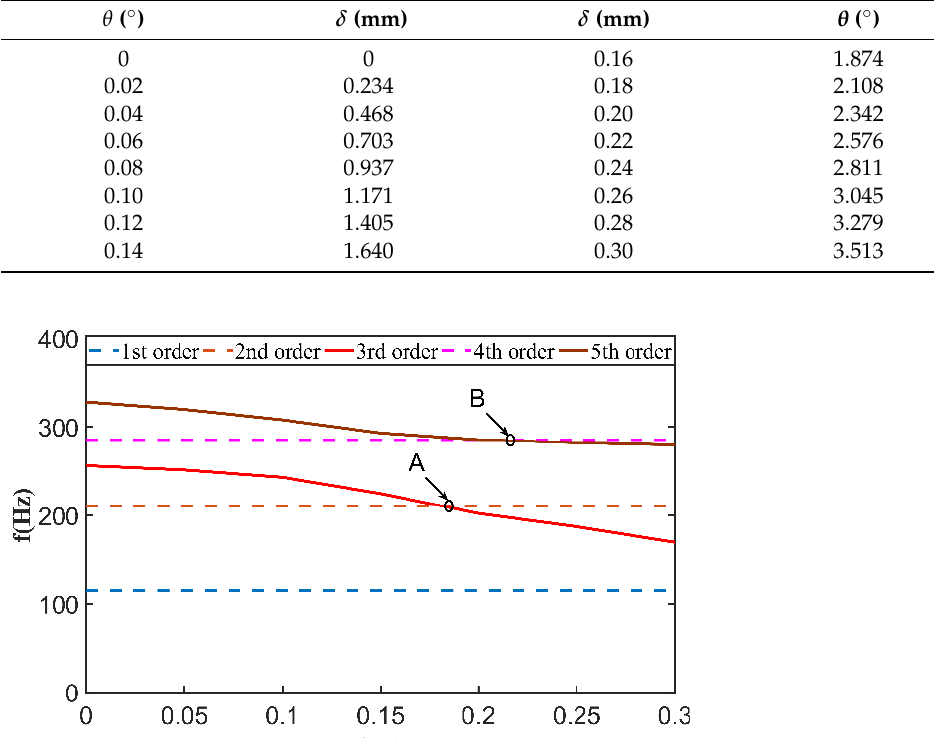
Table 5. The relationship between θ and δ .